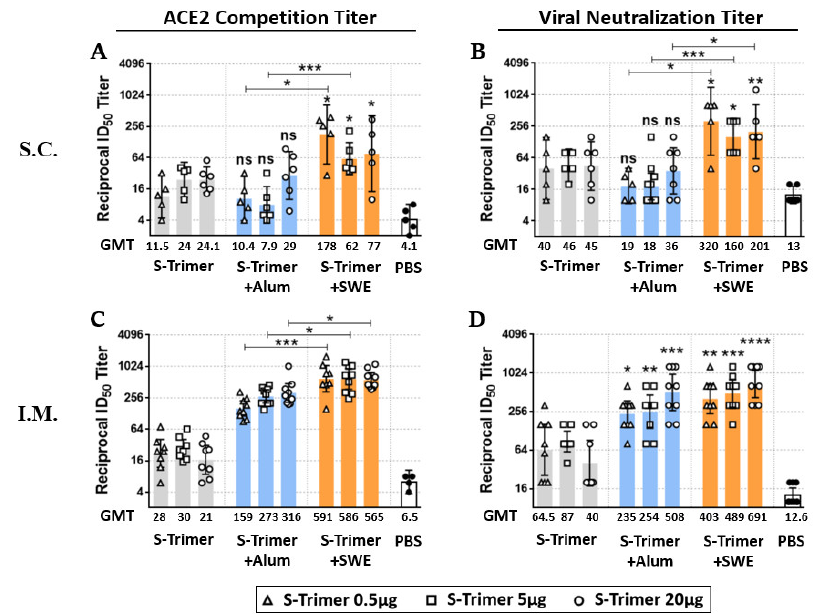
Figure 3. Analysis of ACE2 competitive and neutralizing antibodies in serum of vaccinated BALB/c mice. Inhibition of ACE2 binding to SARS-CoV-2 S-2P and live SARS-CoV-2 virus neutralization were accessed in serum (Day 42) collected from BALB/c mice after the second vaccination dose via ( A , B ) subcutaneous injection, n = 5–6/group, or ( C , D ) intramuscular injection, n = 8–9/group. Each symbol represents the reciprocal 50% inhibitory dilution ID 50 titer from an individual mouse; each bar represents the geometric mean ± 95% CI ID 50 titer from the group. Statistically significant differences were compared with the nonadjuvant vaccine group or adjuvanted vaccine group by two-tailed Mann–Whitney test. * p < 0.05, ** p < 0.008, *** p < 0.0005, **** p < 0.0001; ns: not significant.